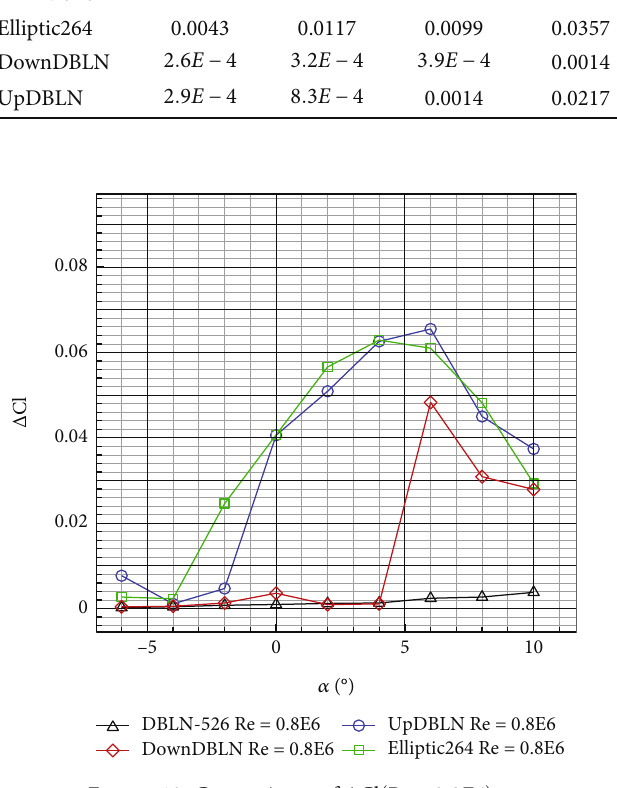
Figure 19: Comparisons of Δ Cl ð Re = 0 : 8 E 6 Þ .